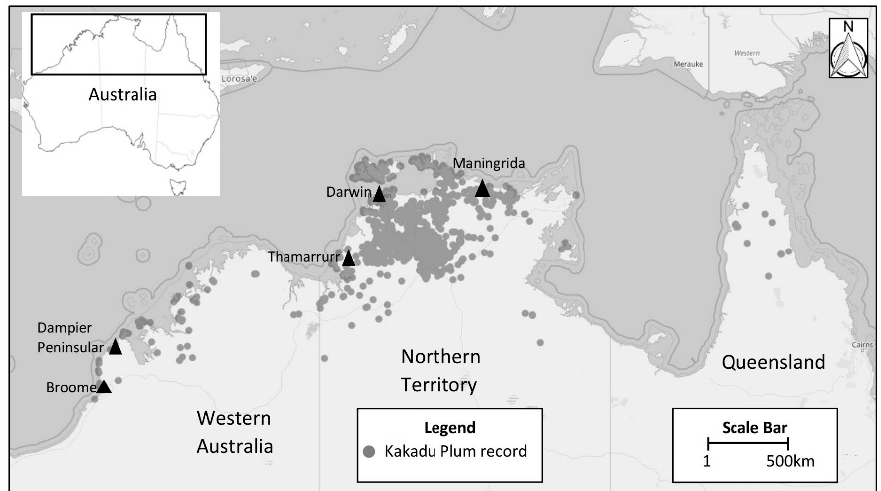
Figure 1. The distribution of the endemic T. ferdinandiana in Western Australia (WA), the Northern Territory (NT) and Queensland (QLD). Triangles represent place names and dots represent herbarium records of T. ferdinandiana, from Atlas of Living Australia [97].